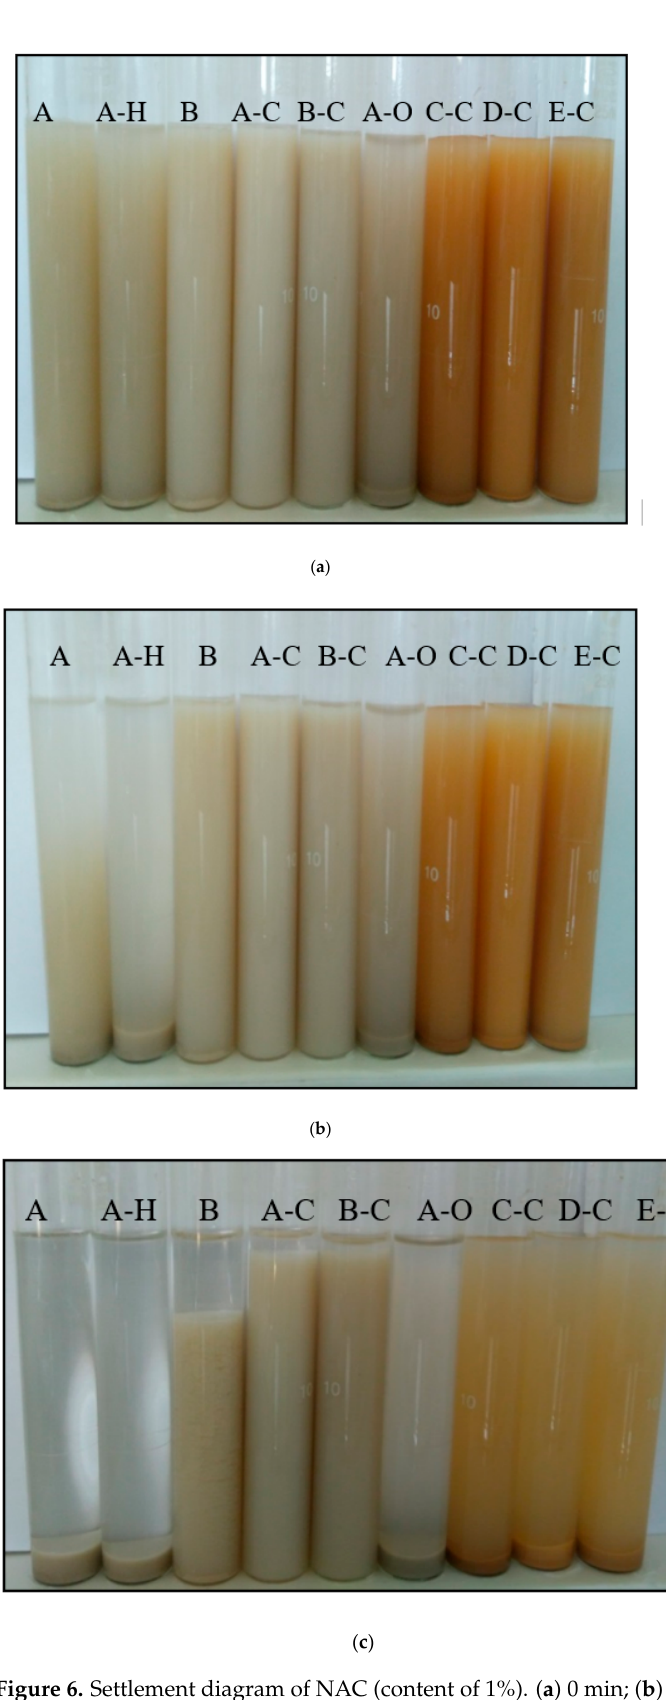
Figure 6. Settlement diagram of NAC (content of 1%). ( a ) 0 min; ( b ) 10 min ; ( c ) 60 min.